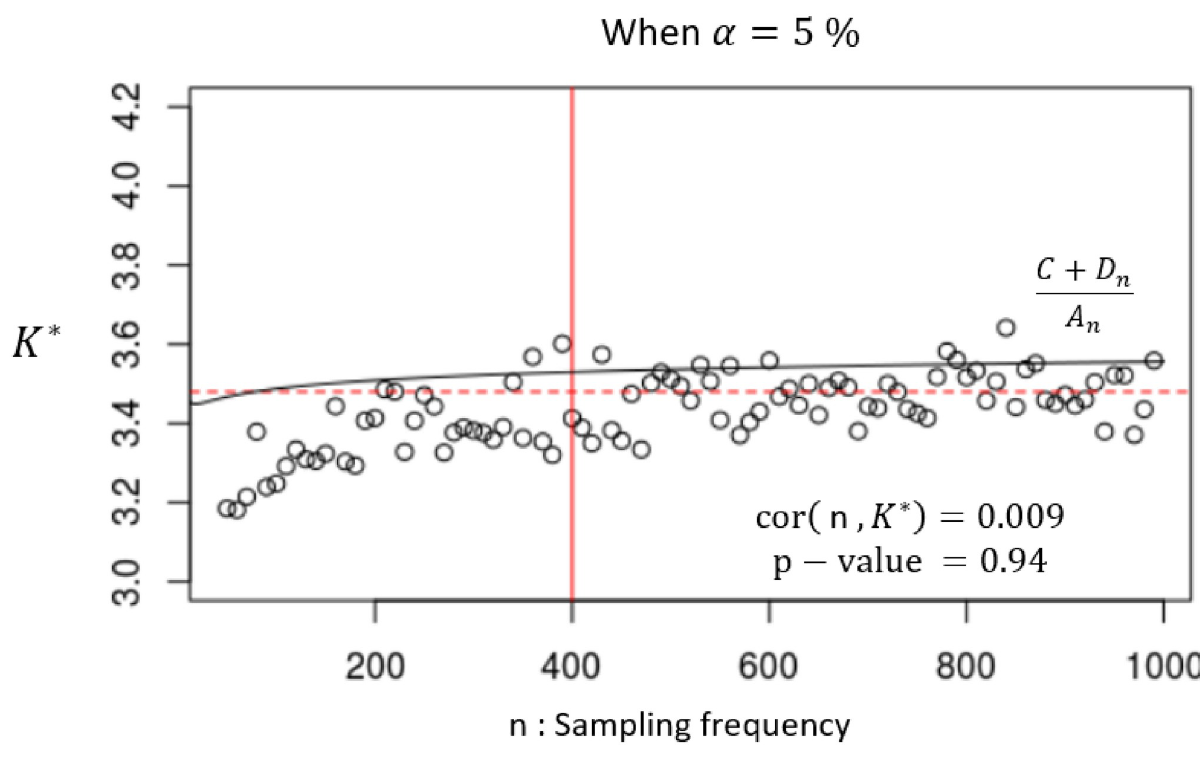
Fig 7. K � v.s. sample size n